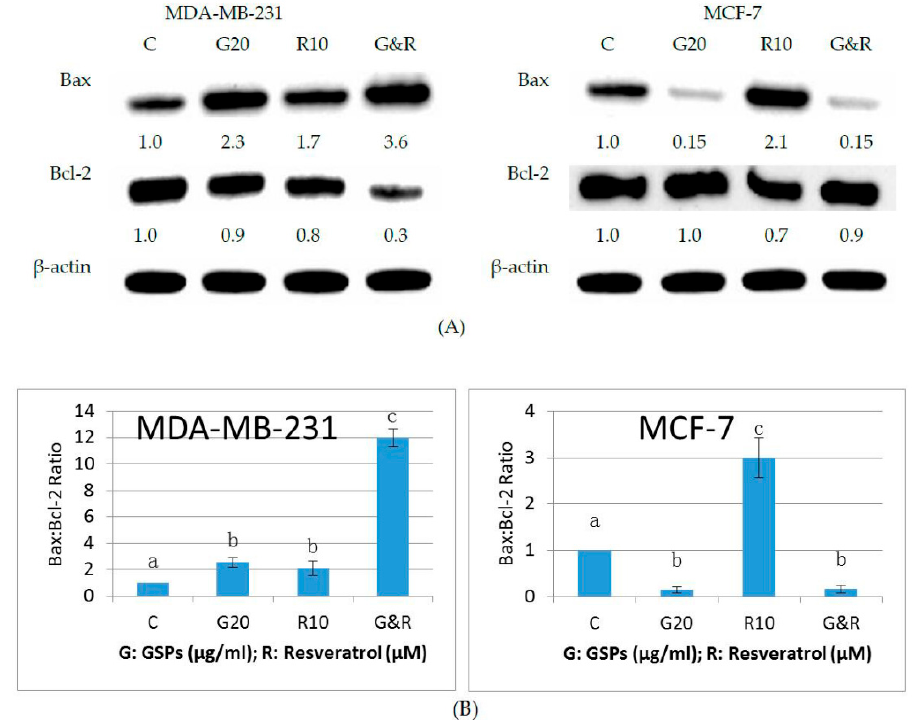
Figure 4. Western Blot Analysis. Change of expression of Bax and Bcl-2 in MDA-MB-231 and MCF-7 human breast cancer cells induced by GSPs (20 µ g/ML), Res (10 µ M), and their combination when compared with the DMSO-treated control groups after treatment for 48 h ( A ). β -actin was used to confirm equivalent loading of the protein samples. The relative density of each band was measured by ImageJ and was shown under each blot of Bax and Bcl-2 after normalization to the control. A representative image was selected from three independent experiments with very similar results. The Bax:Bcl-2 protein ratio is represented as the mean ± SD ( B ). Mean values without any same superscript letter were considered significantly different ( p <